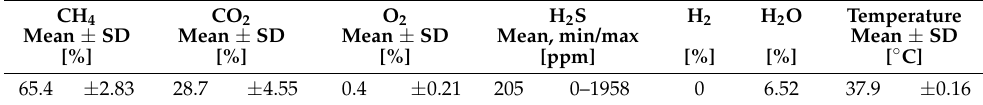
Table 5. Raw biogas composition at the input to the trickling bed reactor, n = 139